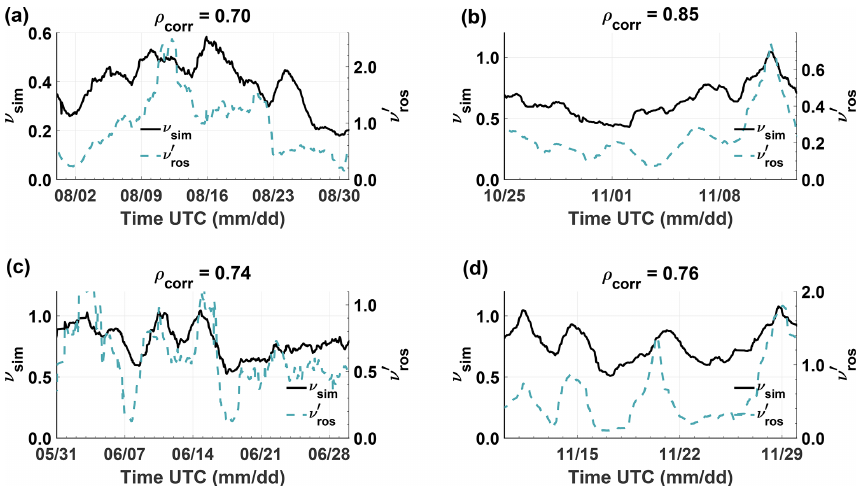
Figure 16. Averaged computed kinematic viscosity ν sim and reference kinematic viscosity ν (cid:48) ros over time for four different time intervals in